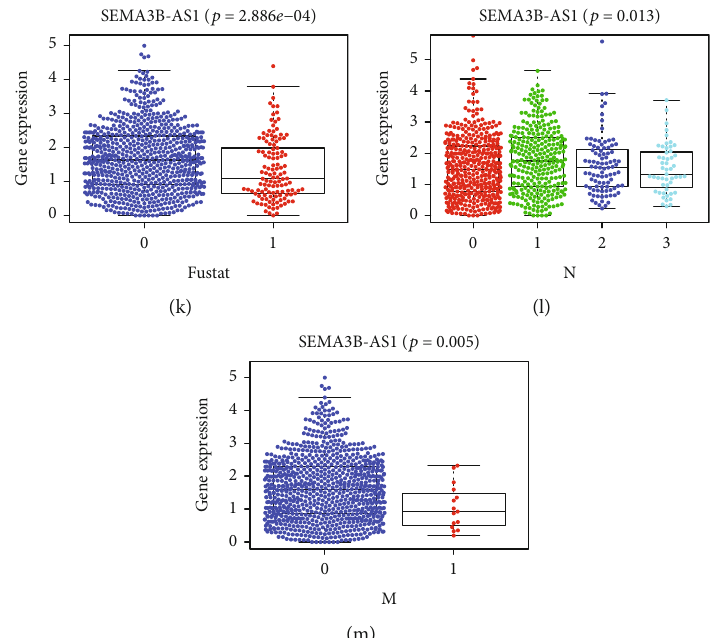
Figure 8: Risk scores and 7 necroptosis-associated lncRNAs were associated with clinical-pathological features in BRCA patients. Correlation between risk score (a – c), LINC01871 (d – f), MAPT-AS1 (g – i), and SEMA3B-AS1 (j – m) and clinical-pathological